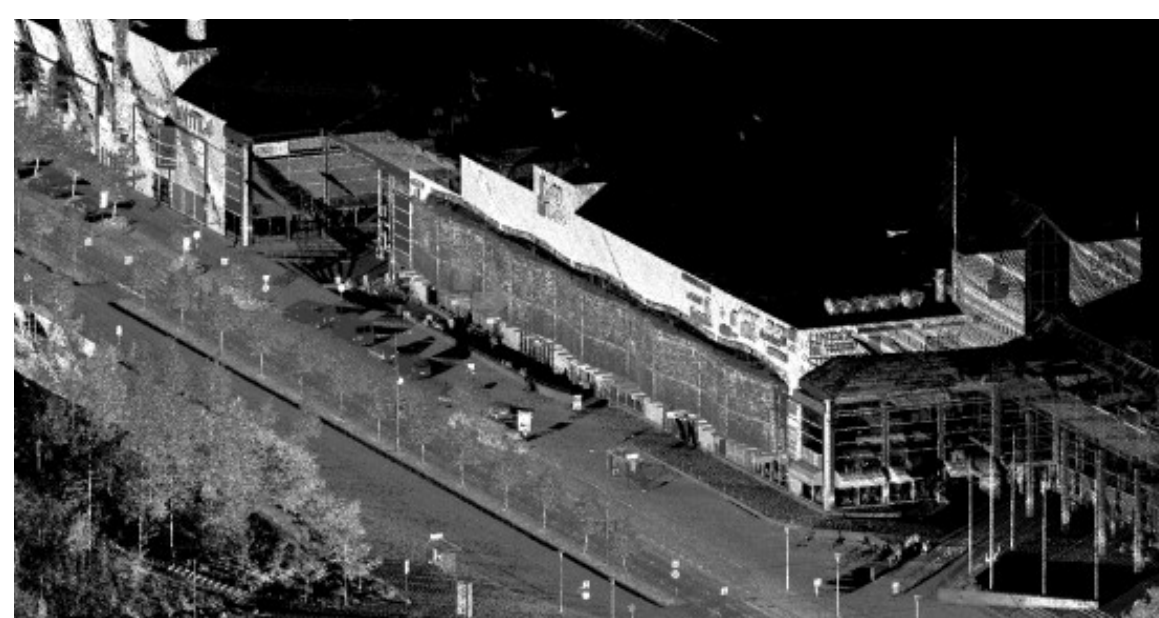
Figure 6. Streetmapper